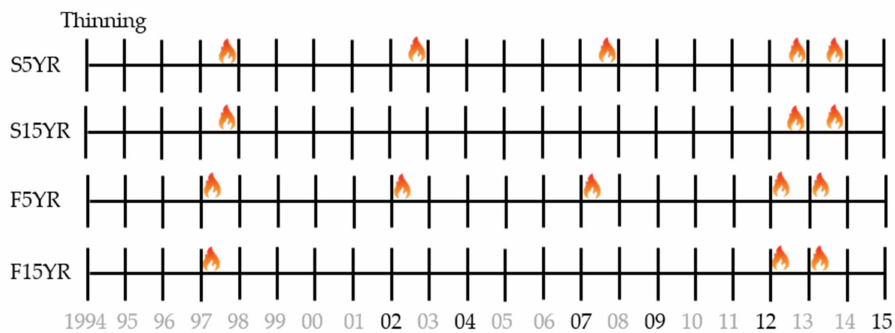
Figure 2. Study timeline of thinning and burning by treatment. Flames denote prescribed burning. S5YR = Spring 5 year burns, S15YR = Spring 15 year burns, F5YR = Fall 5 year burns, and F15YR =